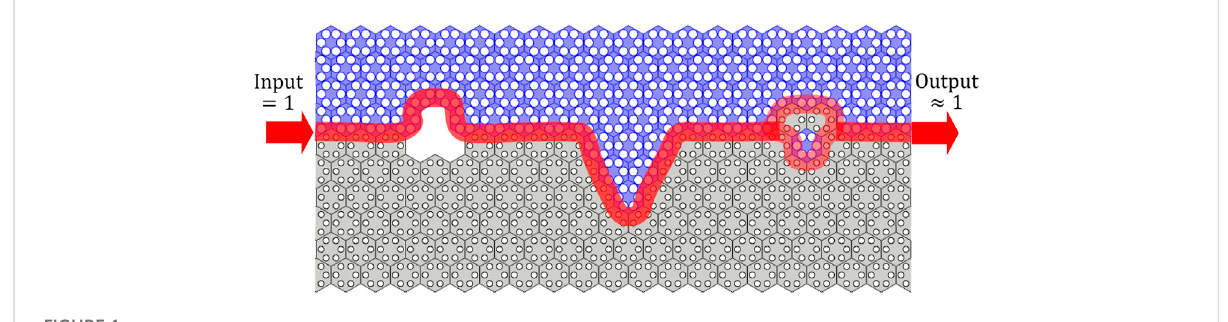
FIGURE 1 An illustration of a topological